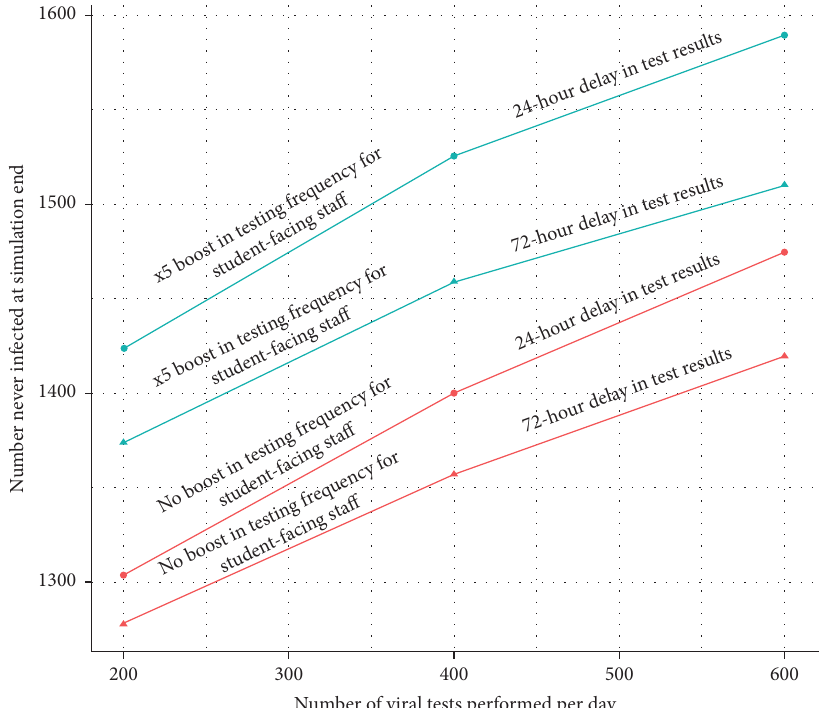
Figure 7: Health outcomes for three testing configurations showing the relative importance of increasing testing frequency for student- facing staff and decreasing the delay in getting test results. In this figure, each curve is a line of fixed cost, illustrating that better health outcomes can be achieved for lower cost, depending on how testing is performed and how rapidly results are received and acted